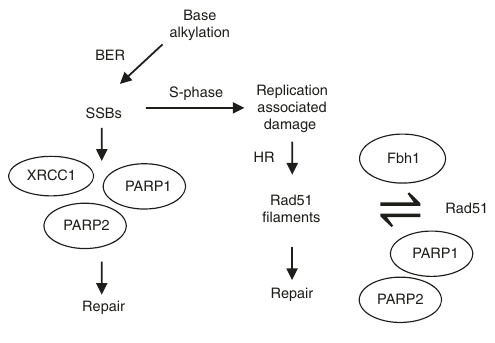
Fig. 6 PARP1 and PARP2 contribute to the resolution of DNA damage caused by base alkylation through two mechanisms. Alkylated bases are processed into DNA single-strand breaks during BER and their repair is accelerated by XRCC1, PARP1 and PARP2. During S-phase, active replication forks can collide with unrepaired SSBs, or SSB repair intermediates, generating replication-associated DNA damage. This damage can be resolved through homologous recombination, which requires the formation of Rad51 fi laments. PARP1 and PARP2